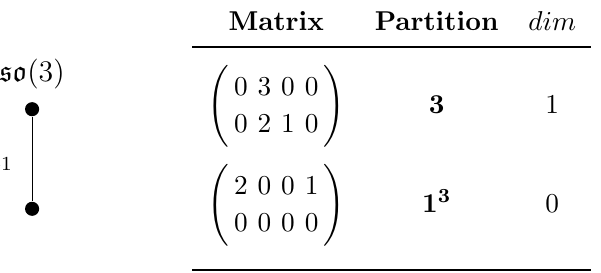
Table 10. Results obtained applying the matrix formalism to so (3).